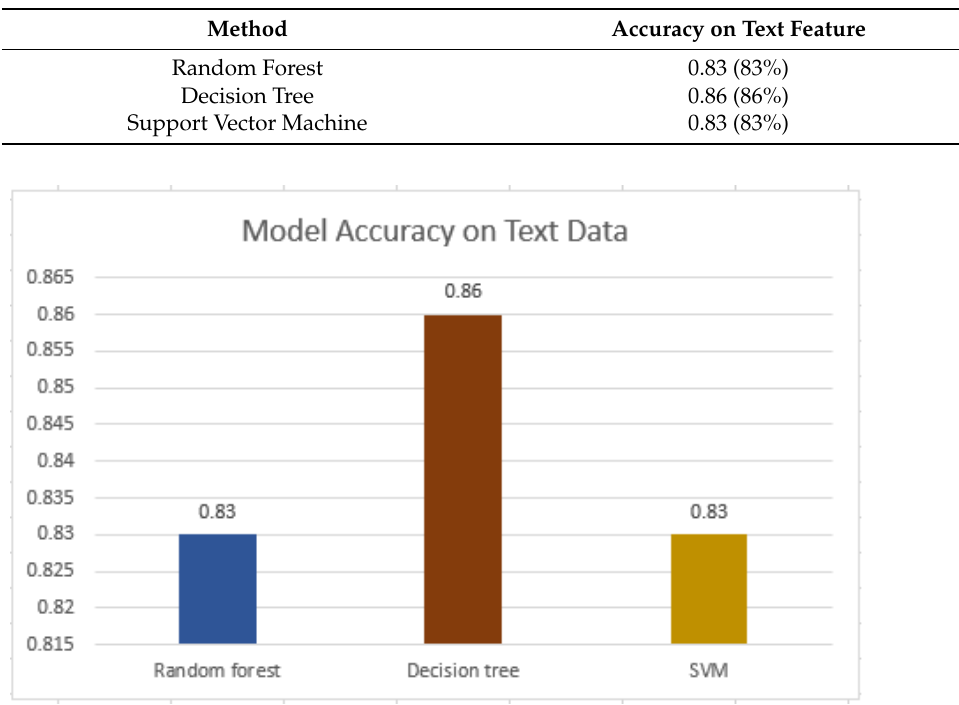
Table 8. Accuracy of all three classifiers on text data.